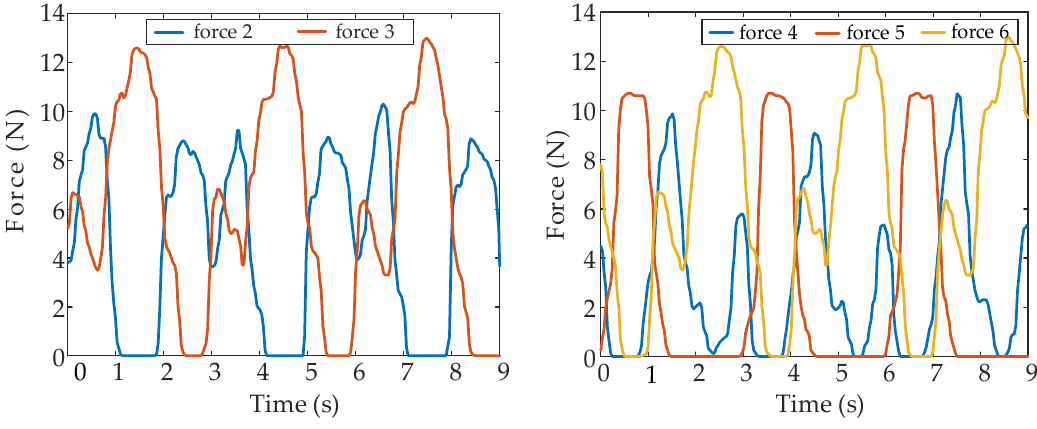
Figure 25. Contact force in leg 1 failure experiment. Appl. Sci. 2020 , 10 , x FOR PEER REVIEW